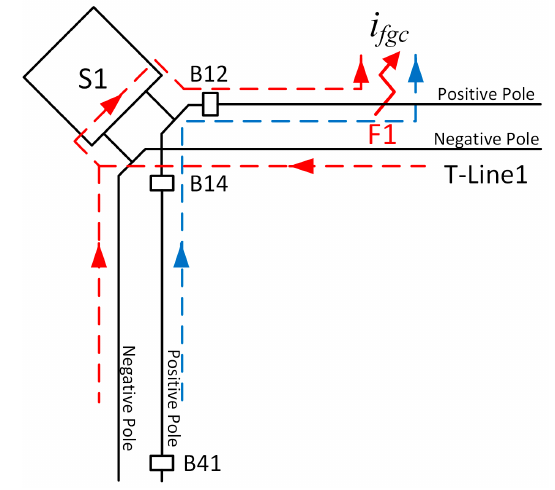
Figure 12. Distribution of i fgc in S1.